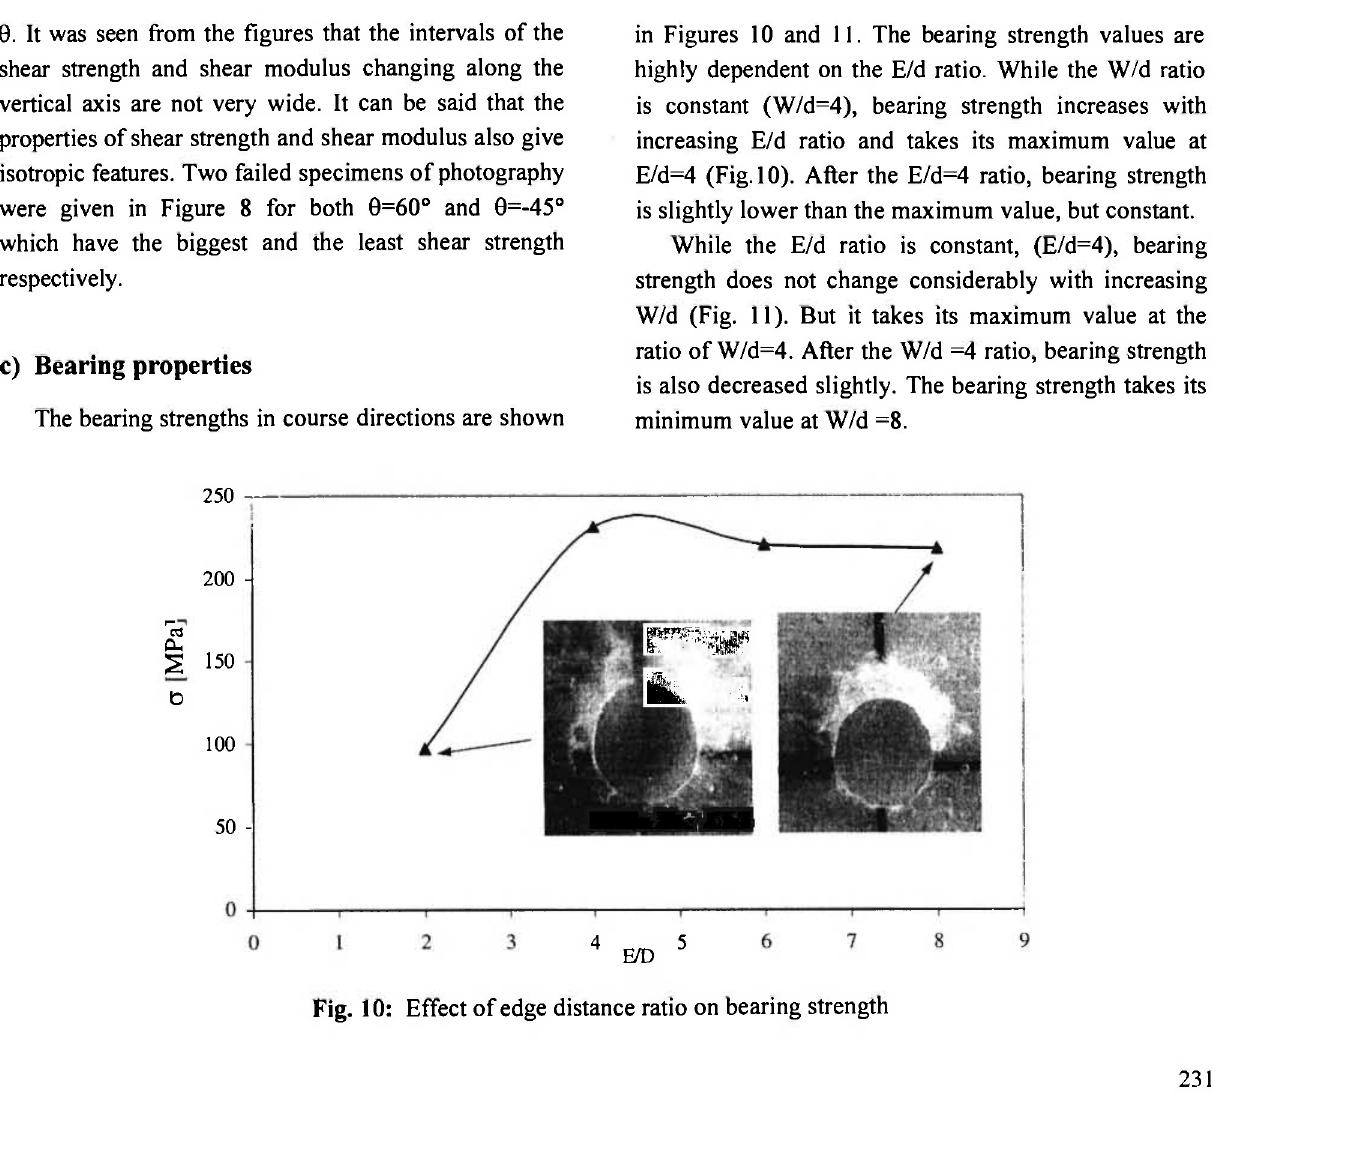
Fig. 10: Effect of edge distance ratio on bearing